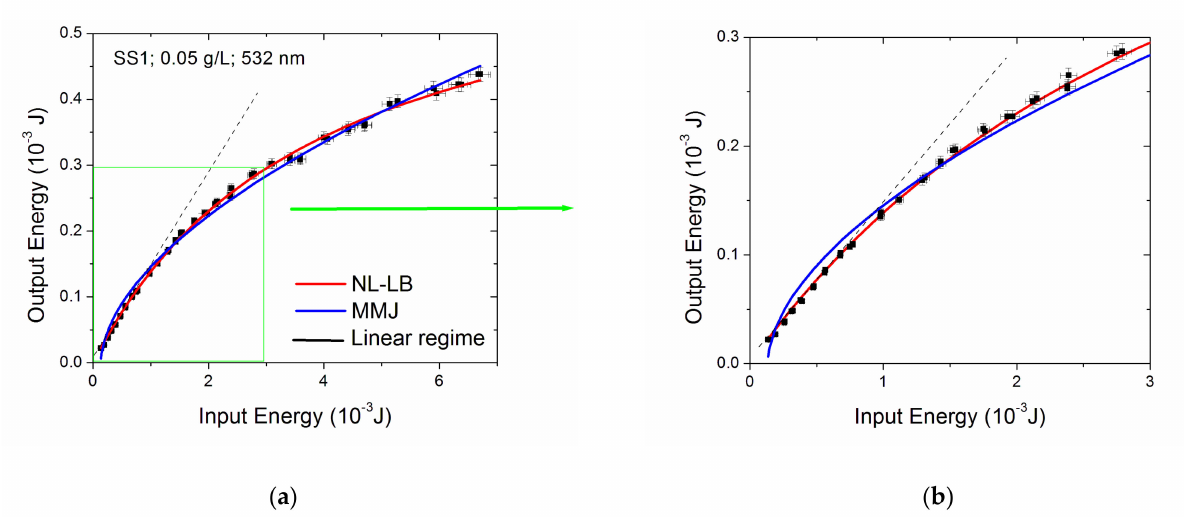
Figure 5. Data fitting for the most concentrated sample and 532 nm wavelength. The first points in ( a ) are depicted larger in the plot ( b ). In both plots, the dashed black line represents the linearity